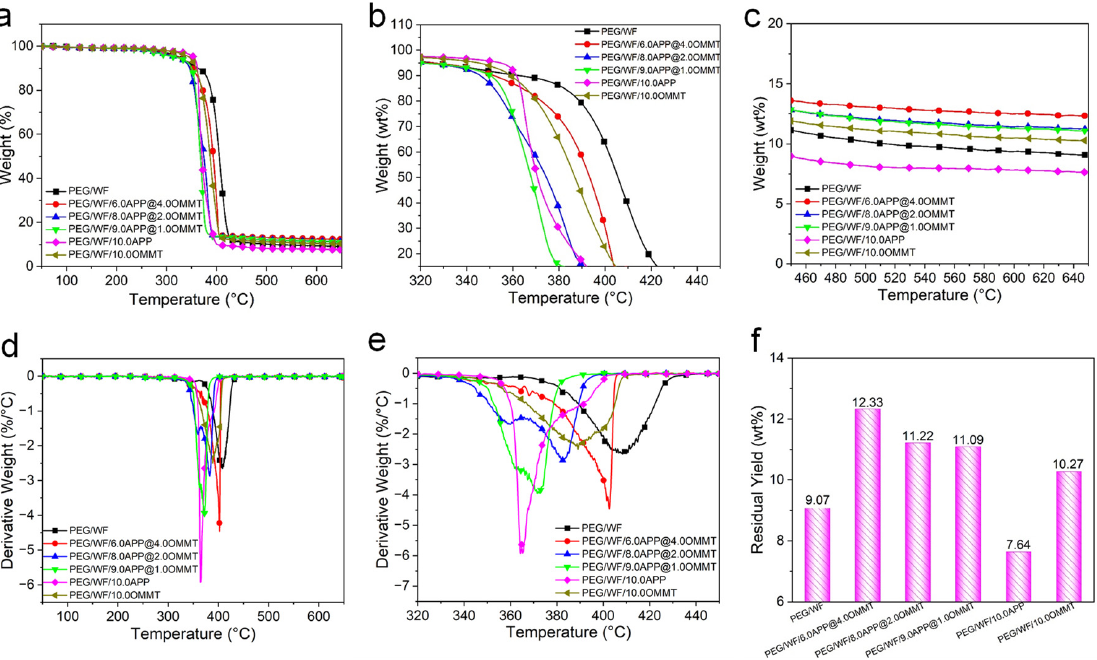
Figure 7. TG ( a – c ), DTG ( d , e ) curves and char yield ( f ) at 650 °C of PEG/WF and its composites. The pure PEG/WF began to degrade at 325 °C and decomposed rapidly at 408 °C.